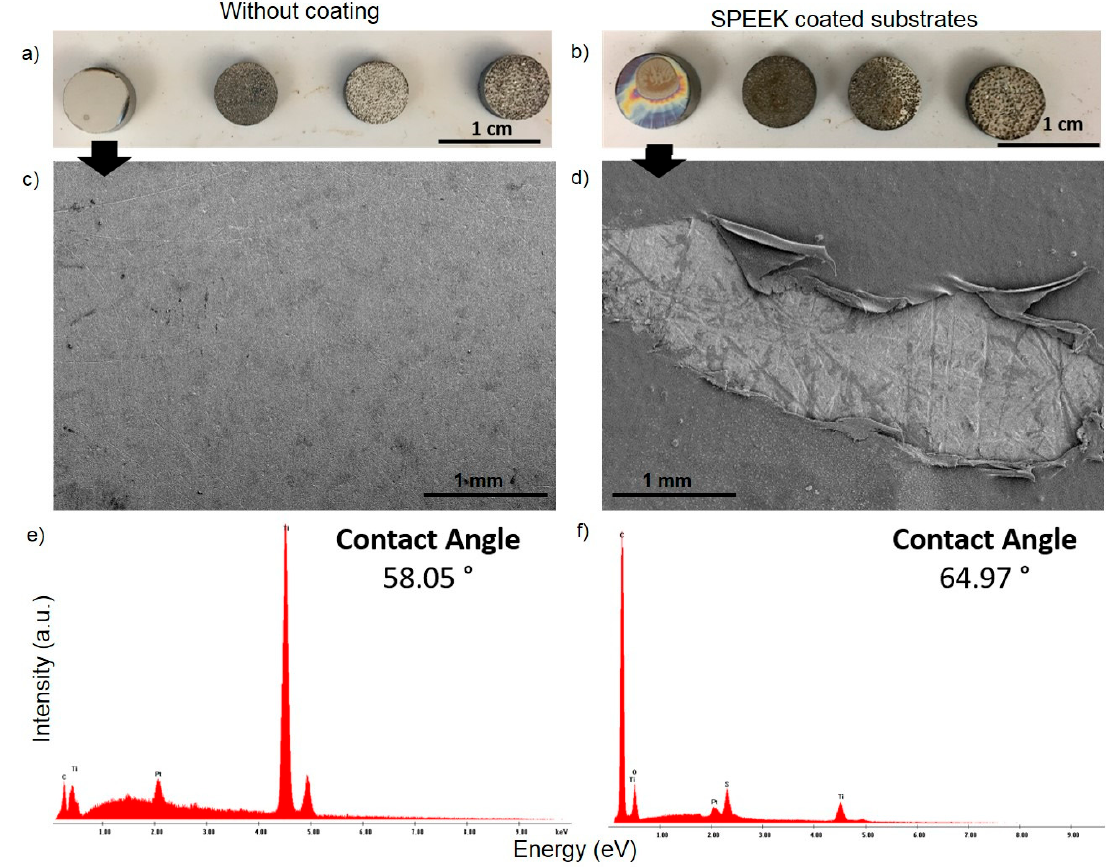
Figure 11. Topography and chemistry surface evaluation of SPEEK coating. Macro-photography of the coated and non-coated samples revealed the presence of the coating ( a , b ), which was confirmed by SEM images of the fully dense surface ( c , d ). A scratch performed in the SPEEK fully-dense samples showed a thin and homogeneous SPEEK film. An energy dispersive spectroscopy (EDS) analysis corroborated the presence of sulfur groups in SPEEK-coated samples as well slightly increased contact angle values due to the increase in sulfur groups in the PEEK structure ( e , f ).